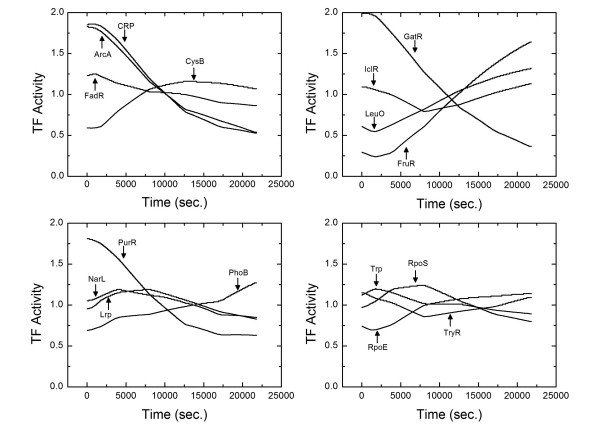
TF activity time courses for 16 of 38 TFs. These results are in qualitative agreement with those obtained by Kao et al. (2003) except for PhoB. pstC and pstS are upregulated by PhoB and their level of expression increases in time (shown in Figure 6), therefore one would expect the activity of PhoB to increase as well.